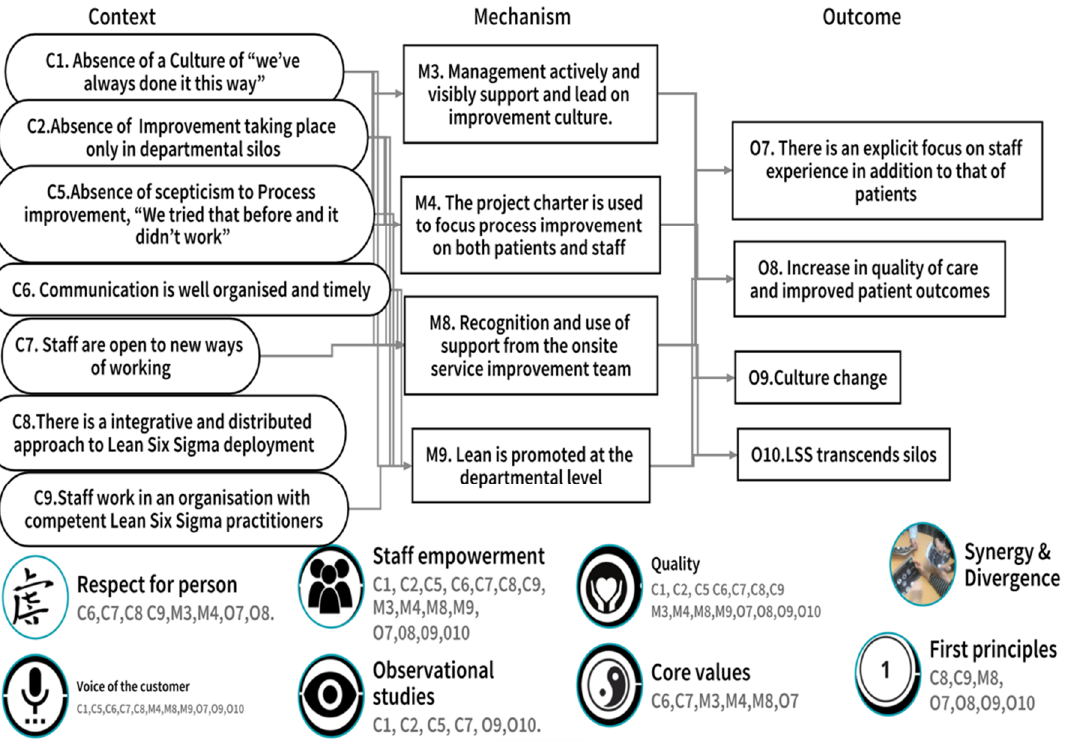
Figure 5. CMOc1 LSS and aspects of organisational